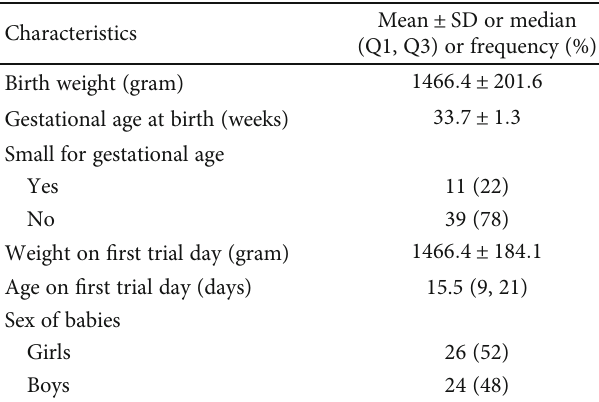
Table 1: General characteristics of babies.